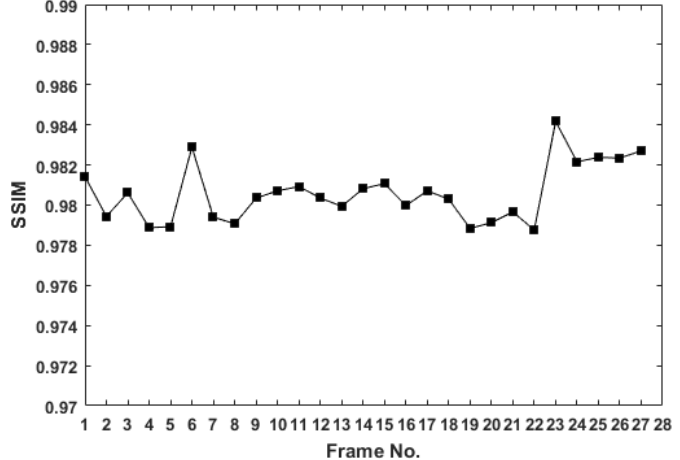
Figure 10. SSIM curve of detection results with reference to the ground truth on different frames of a video sequence with semi-cluttered